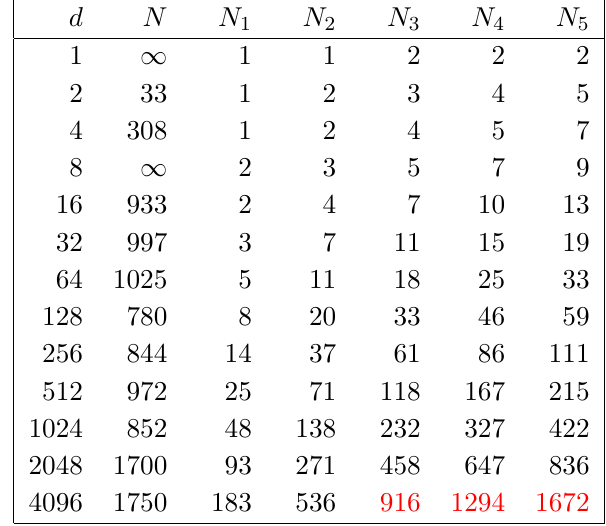
Table 4 . The truncation order N k required to approximate (log so that rounding to k decimal places leads to error at most 10 − k